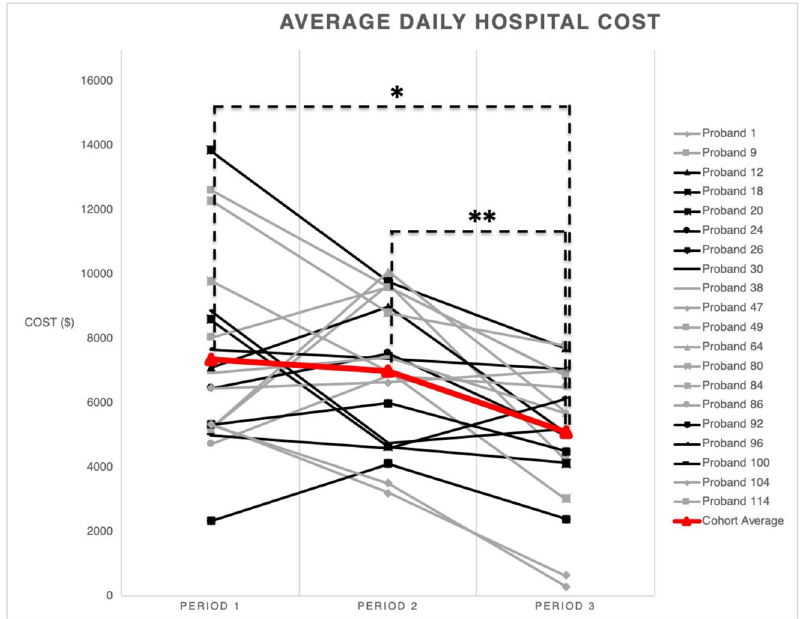
Fig. 3 Temporal trends in hospital costs around the time of rWGS testing. Evaluation of spending trend surrounding the rWGS process showed an overall decreased spending post rWGS results (Supplementary Table 2b). There is a signi fi cant association between time period and cost ( p = 0.01; repeated measures ANOVA). Speci fi cally, there is a signi fi cant difference in cost between periods 1 and 3 (mean difference 2266.4; 95% CI 1035.6 – 3497.1; * p = 0.001; paired t -test) and periods 2 and 3 (mean difference 1917.1; 95% CI 1077.2 – 2756.9; ** p = 0.0001; paired t -test). There is not a signi fi cant difference in cost between the nondiagnostic and diagnostic groups by time period ( p = 0.70; repeated measures